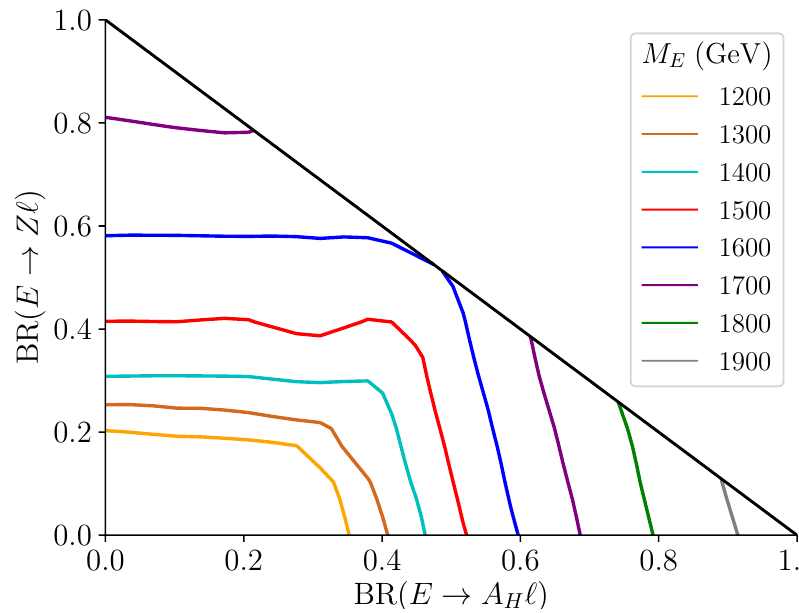
Figure 11 . Projected limits on the mass of the VLL, M E for arbitrary branching fractions for the HE-LHC. (See text and figure 9 for